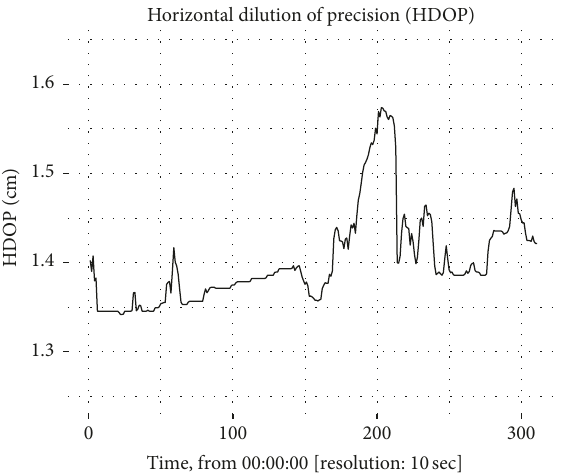
Figure 14: Computed HDOP values. Baseline of ∼ 41km, year: 2014, DOY: 85.